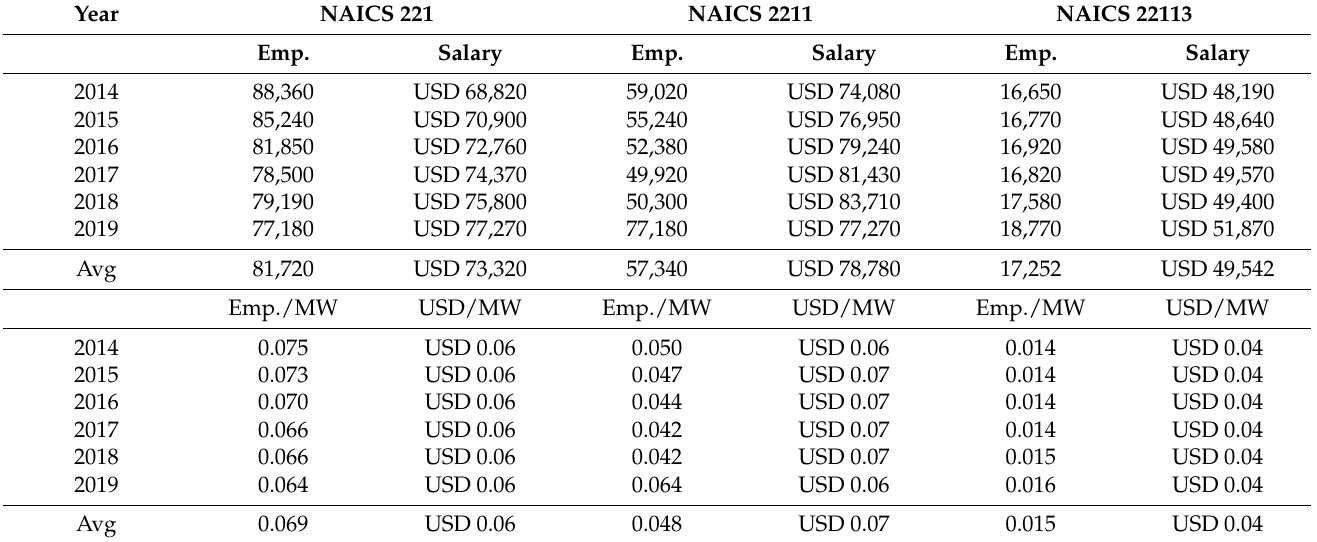
Table 4. Employment numbers and mean annual salary in production occupations per year’s generator capacity (MWh) for Utilities (NAICS 221), Electric power generation, transmission and distribution (NAICS 2211), and Water, sewage, and other systems (NAICS 22113). Avg is average. Year NAICS 221 NAICS 2211 NAICS 22113 Emp. Salary Emp. Salary Emp.